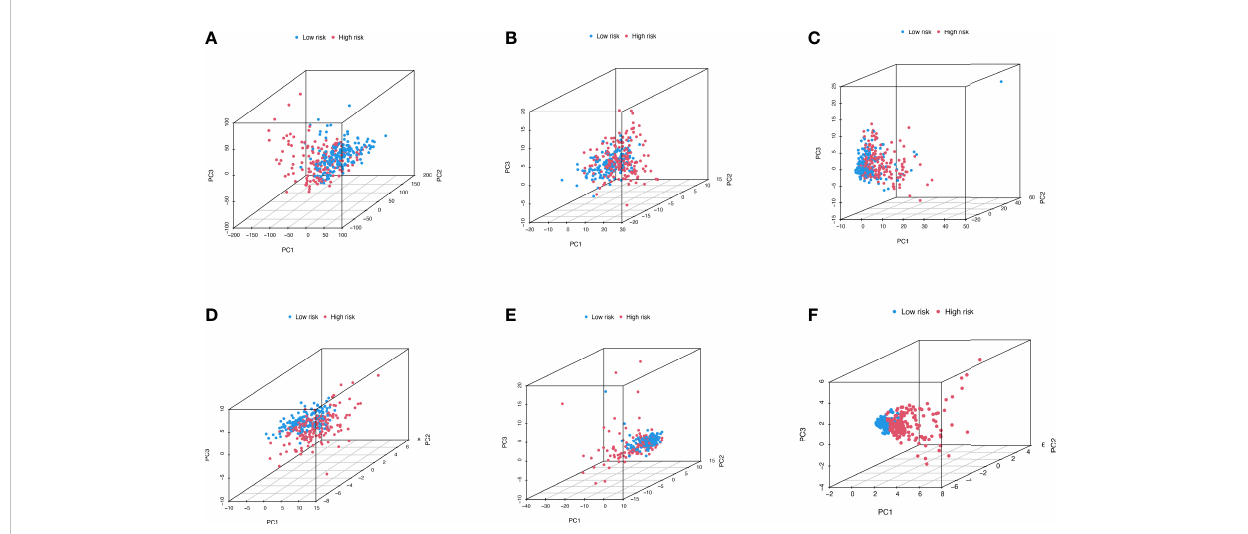
FIGURE 6 PCA dimensionality reduction analysis distinguishing between high- and low- risk groups for (A) entire gene expression in LIHC cohort; (B) 259 ferroptosis-related genes in high- and low-risk groups; (C) 174 ferroptosis-related lncRNAs (FRLRs) in high- and low-risk groups; (D) 67 necroptosis- related genes in high- and low-risk groups; (E) 319 necroptosis-related lncRNAs (NRLRs) in high- and low-risk groups; (F) Five ferroptosis- and necroptosis-related lncRNAs (F-NLRs) in high- and low-risk